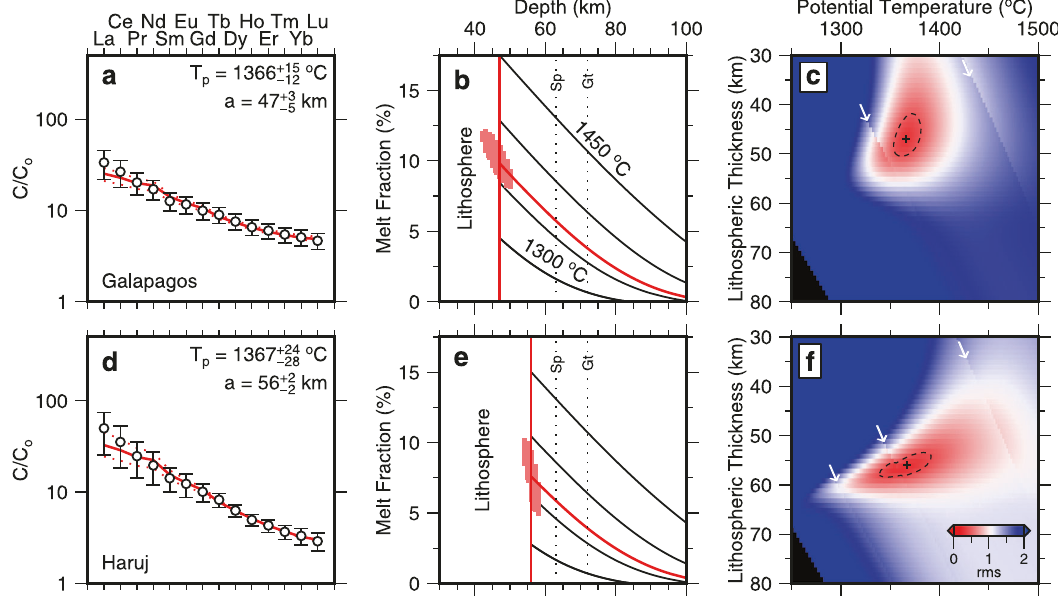
Fig. 4 Inverse modeling of rare earth element (REE) concentrations. a Galápagos Islands, Ecuador (0 ± 0.5°N, 92 ± 0.5° W). Open circles with vertical bars = average REE concentrations ± σ normalized with respect to source composition where ε Nd = 6.21; red line = REE concentrations calculated by inverse modeling where residual rms value at global minimum is 0.31; pair of dotted red lines = calculated REE concentrations where residual rms value is 1.5× that at global minimum. Optimal values and associated uncertainties of potential temperature, T p , and of lithospheric thickness, a , displayed at top right-hand side. b Melt fraction plotted as function of depth. Curved red line = melt fraction calculated by fi tting observed REE concentrations in panel a ; vertical red line = calculated top of melting column; pink polygon = range of uncertainty for T p and a at top of melting column calculated from suite of models where residual rms value is 1.5× that at global minimum; black lines = set of isentropic curves calculated using parametrization of ref. 42 corrected for appropriate water content and labeled by values of potential temperature; pair vertical dotted lines at 63 and 72 km = limits of spinel-garnet transition zone 37,43 . c Mis fi t between observed and calculated REE concentrations plotted as function of T p and a where color scale of rms value calculated using Eq. (22) is given in bottom right-hand corner of panel f ; black cross = locus of global minimum; dashed black line indicates 1.5 × rms value at global minimum; white arrows = loci of phase transitions. d – f Same for Al-Haruj province, Libya (28 ± 0.5°N, 18 ± 0.5°E) where ε Nd = 5.18 and rms value at locus of global minimum =